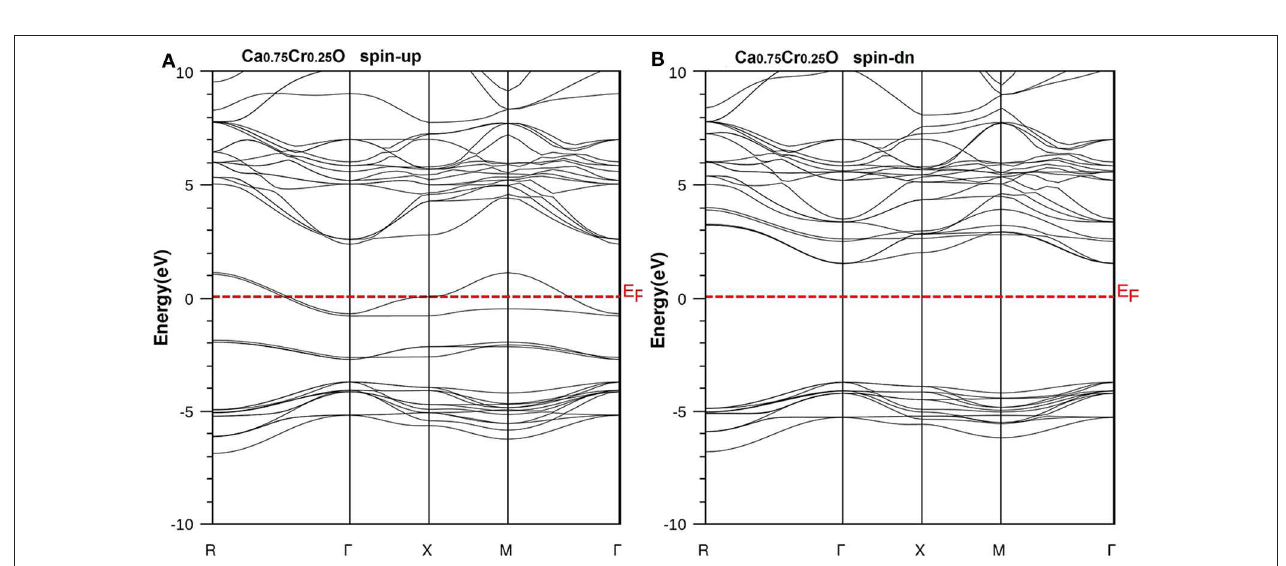
FIGURE 5 | Band structures of Ca 0.75 Cr 0.25 O. (A) Majority spins ( up ) and (B) minority spins ( dn ). The Fermi level is set to zero ( horizontal dotted line ).